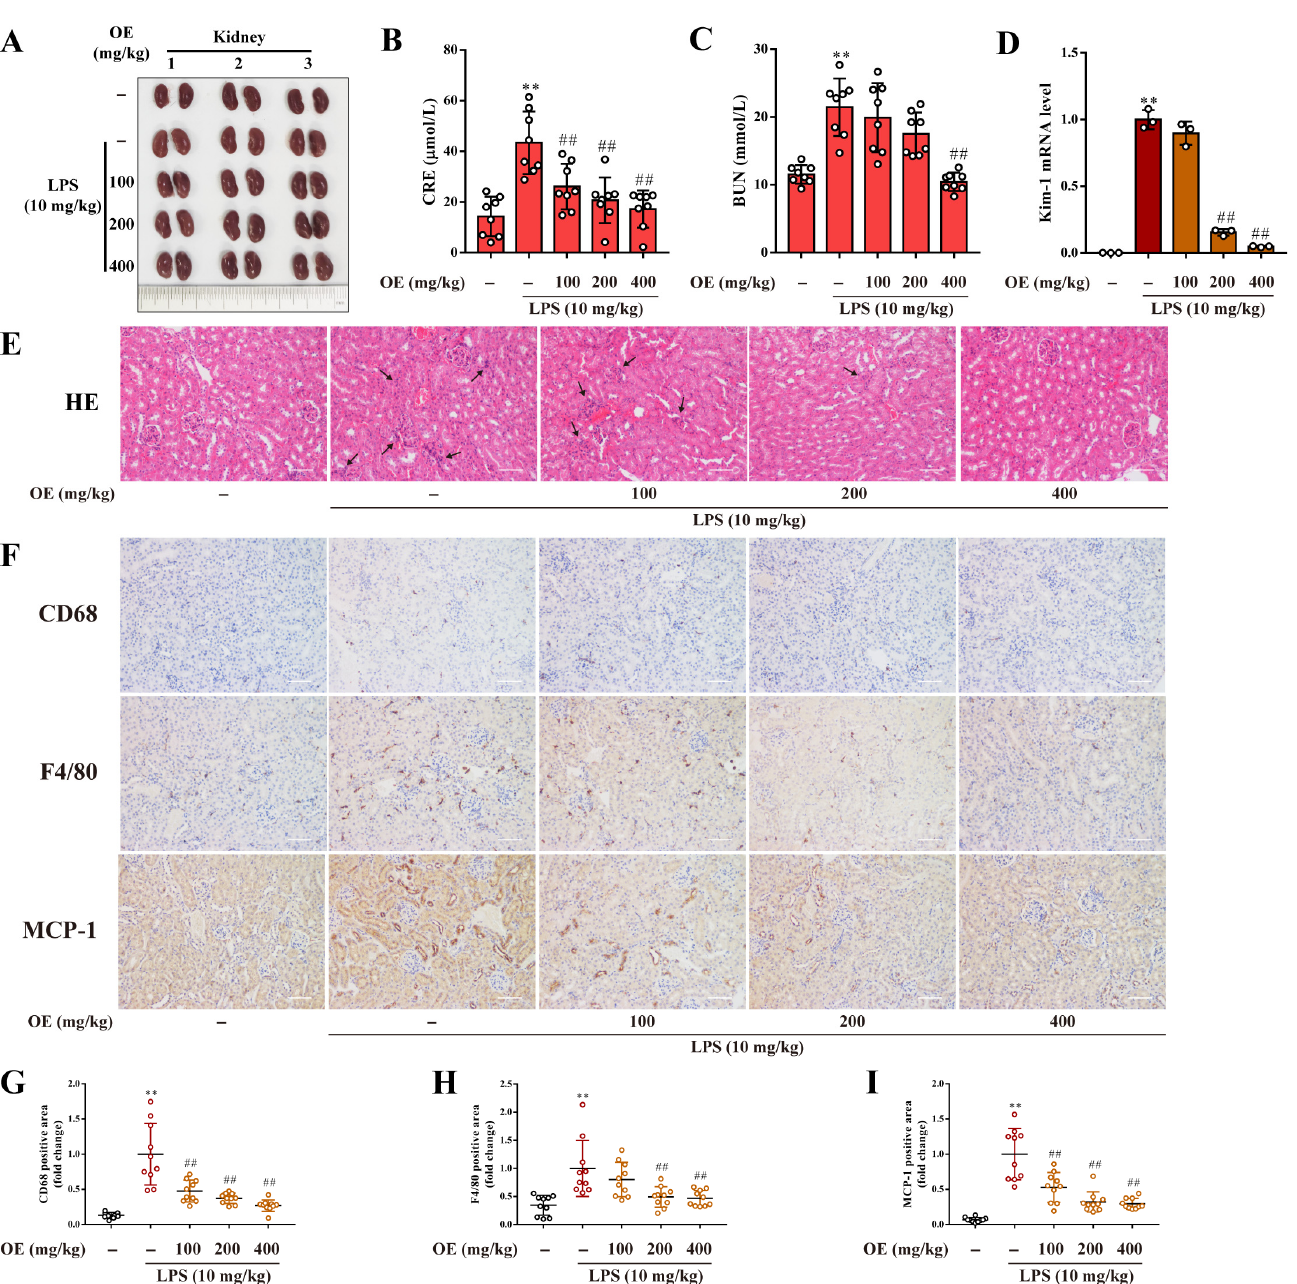
Figure 6. OE ameliorated LPS-induced AKI in mice. ( A – I ) Mice were administered OE (100, 200, 400 mg/kg) by gavage for 7 days followed by an intraperitoneal injection of LPS (10 mg/kg) and feeding for another 12 h. Kidney morphology ( A ) was observed. Serum CRE ( B ) and BUN ( C ) levels were measured by kits according to the manufacturer’s instructions. The mRNA level of Kim-1 in mice kidney was determined by quantitative real time PCR ( D ). Histopathology of kidneys was analyzed by HE staining ( E ). Arrows indicate the infiltration of inflammatory cells. Scale bars: 50 μ m. Immunochemical analysis was applied to determine expression of CD68, F4/80, and MCP-1 in mice kidneys ( F – I ). Scale bars: 50 μ m. Data presented as Means ± SD. ** p < 0.01 vs. control group; ## p < 0.01 vs. LPS group; ns, no significance.